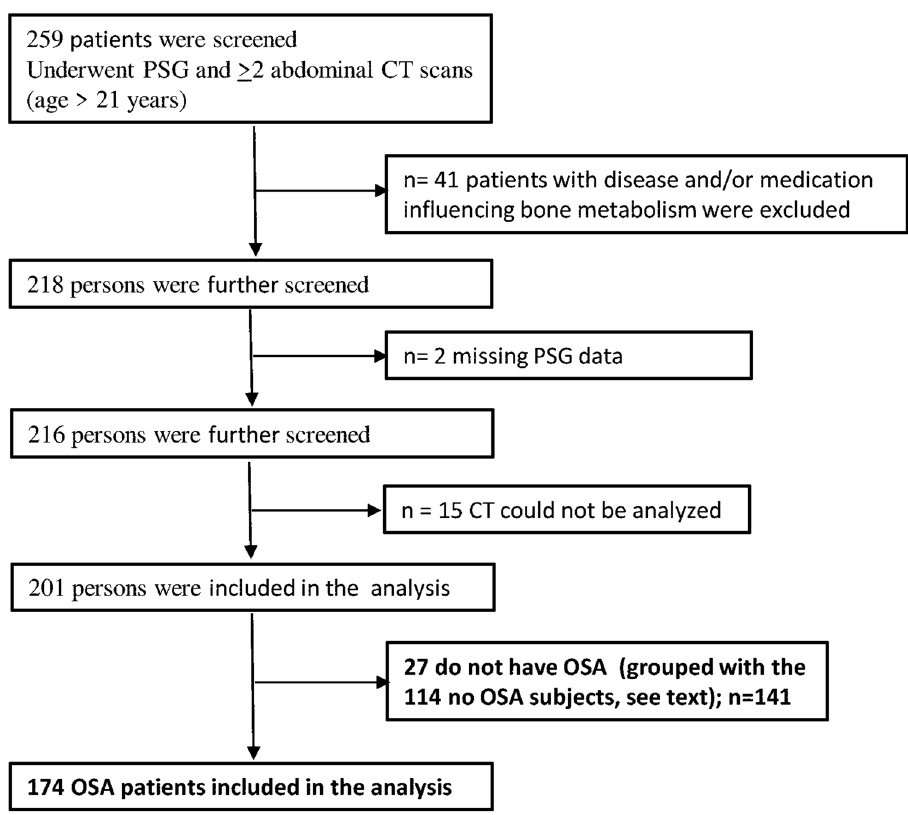
Figure 1. Flow chart of study participants.